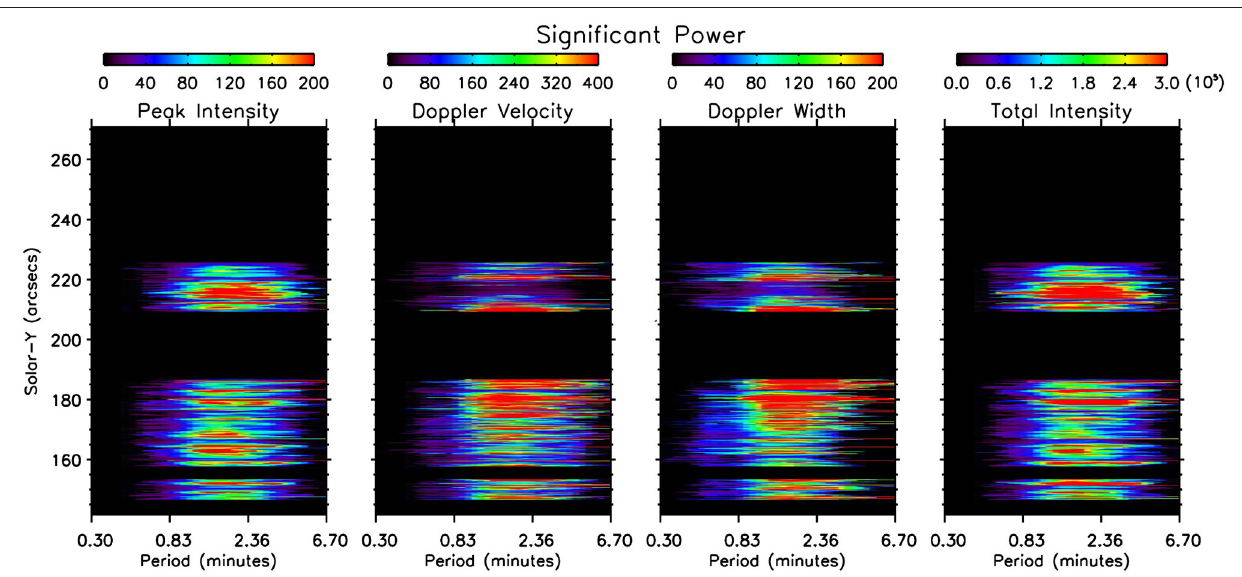
FIGURE 4 | Power maps showing the significant power obtained from the variation of different spectral parameters of SiIV1403Å emission line in the period range of 0.3–6.7